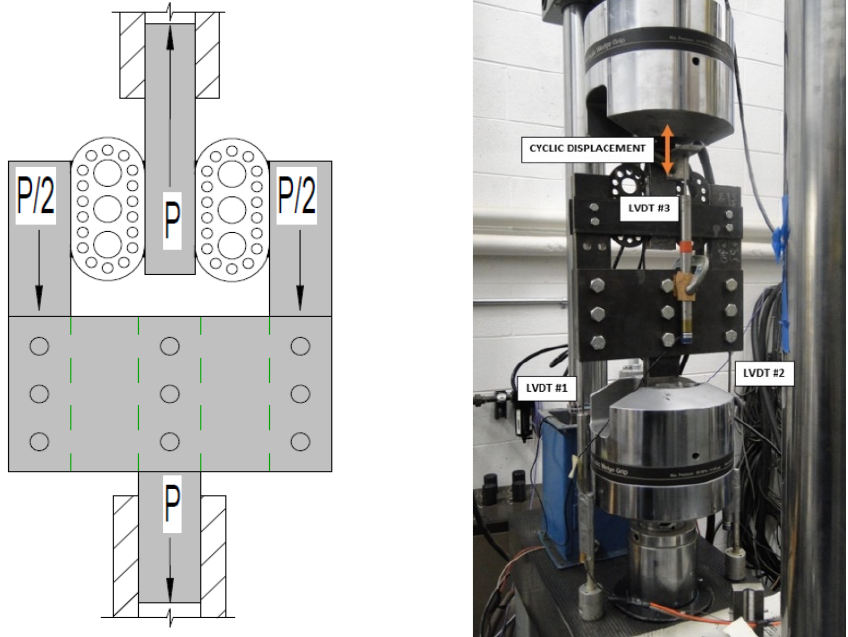
Figure 12. MYZ test setup between the jaws of the universal test machine.